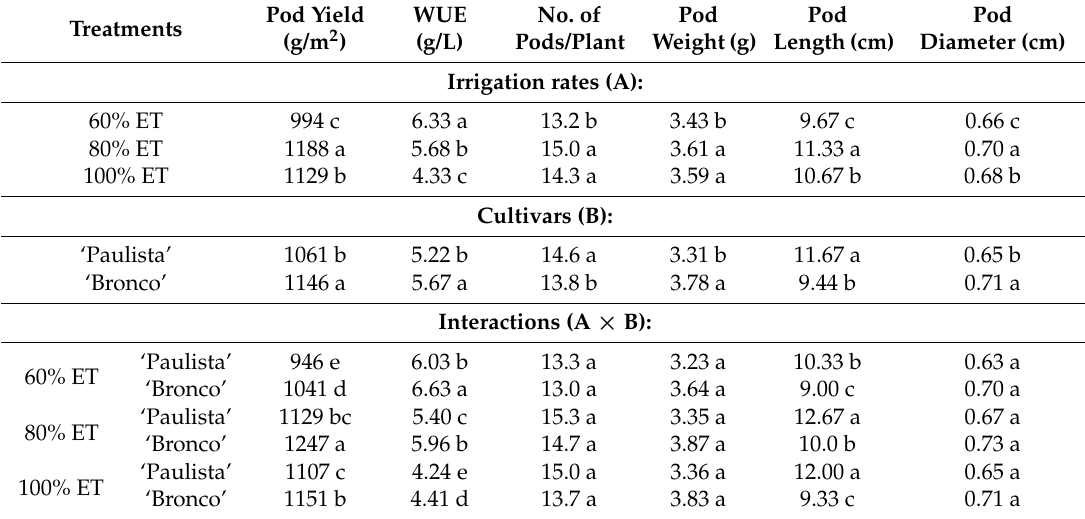
Table 3. Effect of different irrigation water volumes based on supplying 60, 80 or 100% of evapotranspiration (ET) on the pod yield, water use efficiency, and pod parameters of two green bean